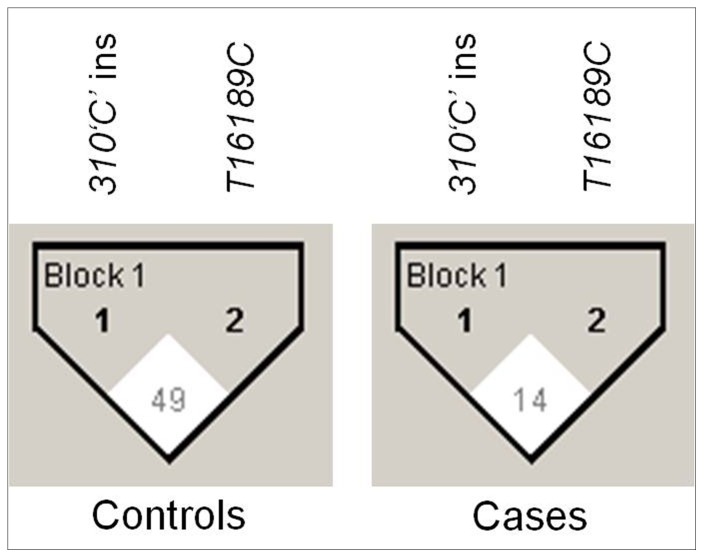
Linkage disequilibrium (LD) analysis of significant D-loop SNPs in cases and controls:Haploview plots are presented along the single nucleotide polymorphisms studied. The pair-wise linkage disequilibrium values (D′ = 0–100) of all significant SNPs are given in each diamond. A value of 100 represents maximum possible linkage disequilibrium.